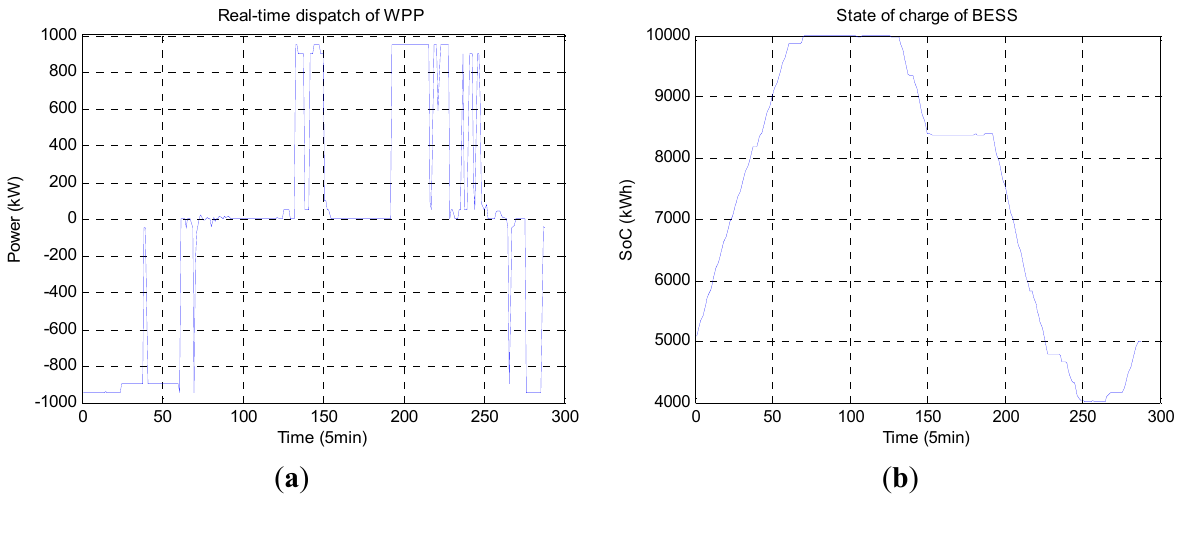
Figure 6. ( a ) The optimal dispatch of WPP; ( b ) The SoC of BES in case